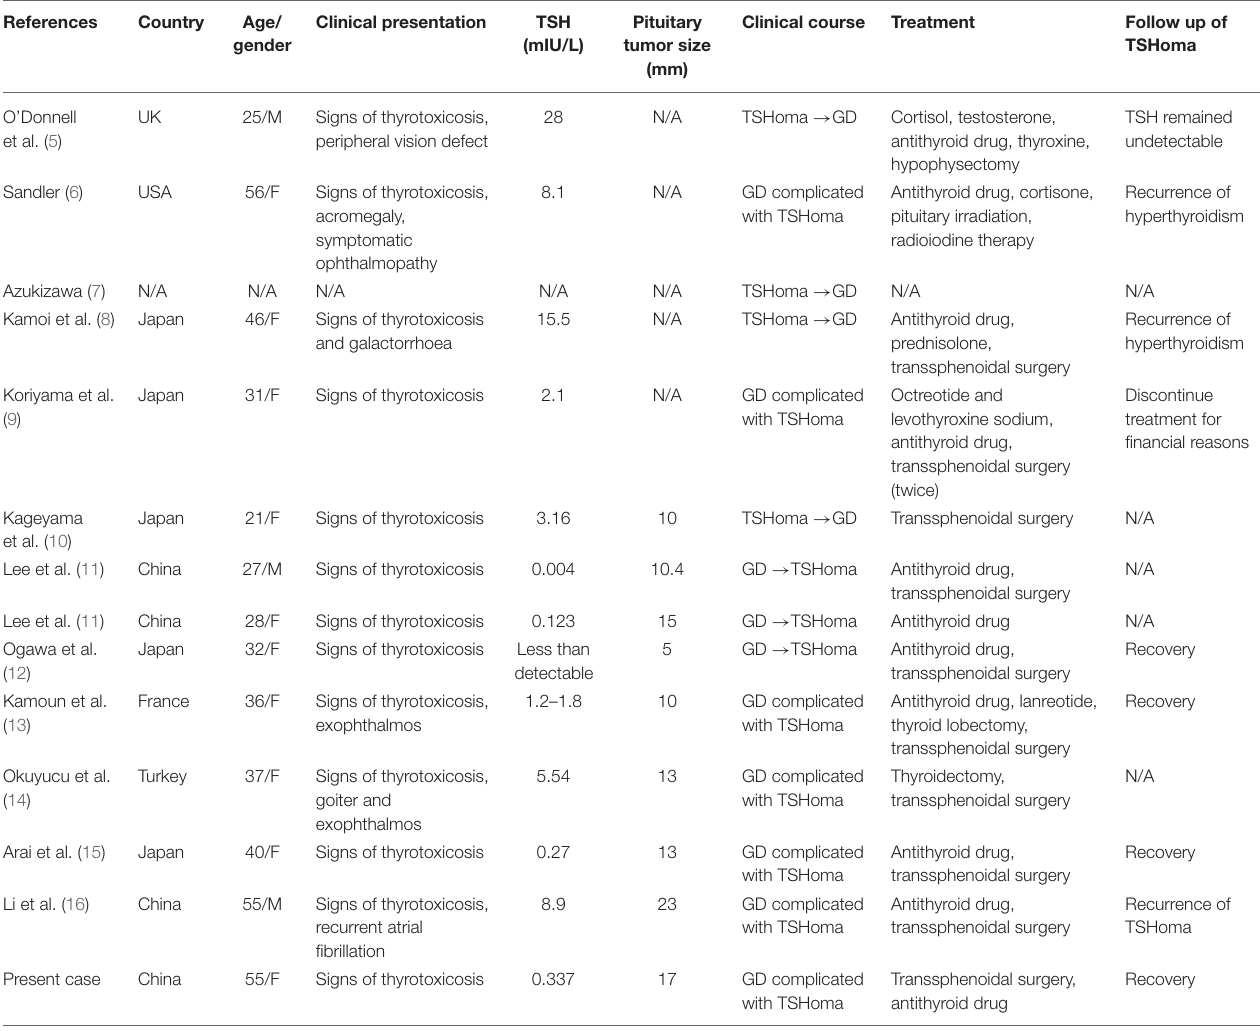
TABLE 2 | Case reports of patients with GD and